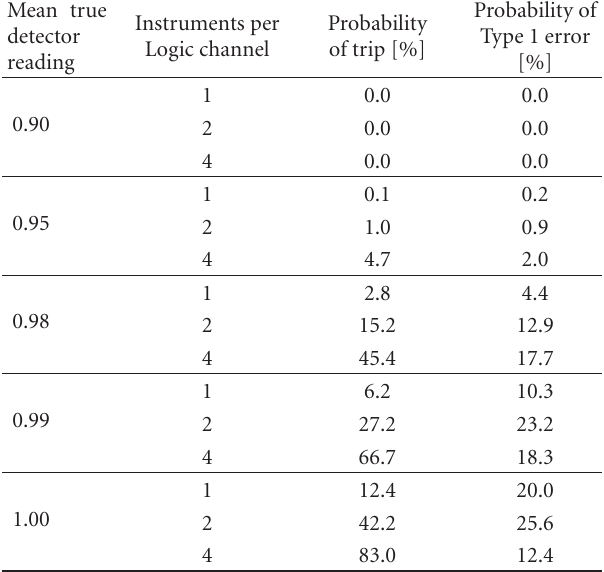
Table 2: Influence of the number of available detectors on the prob- ability of missing a required